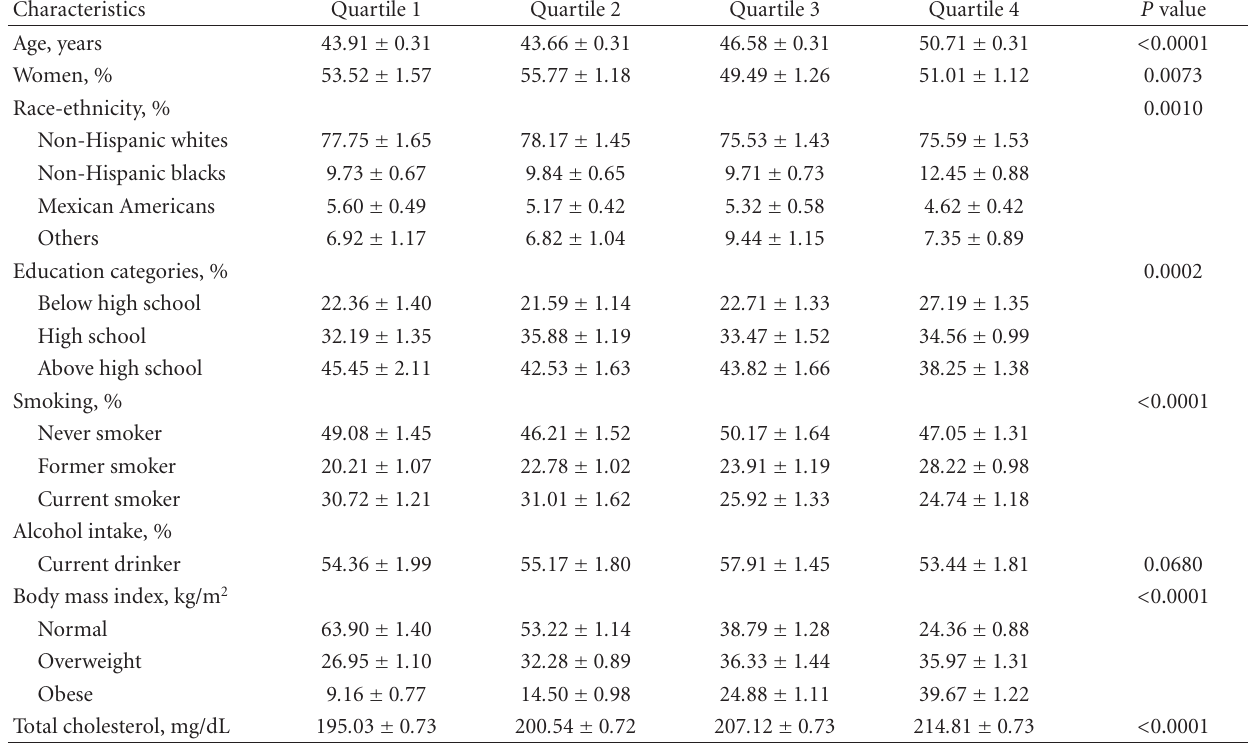
Table 1: Characteristics of the study population by categories of serum uric acid level ∗† .